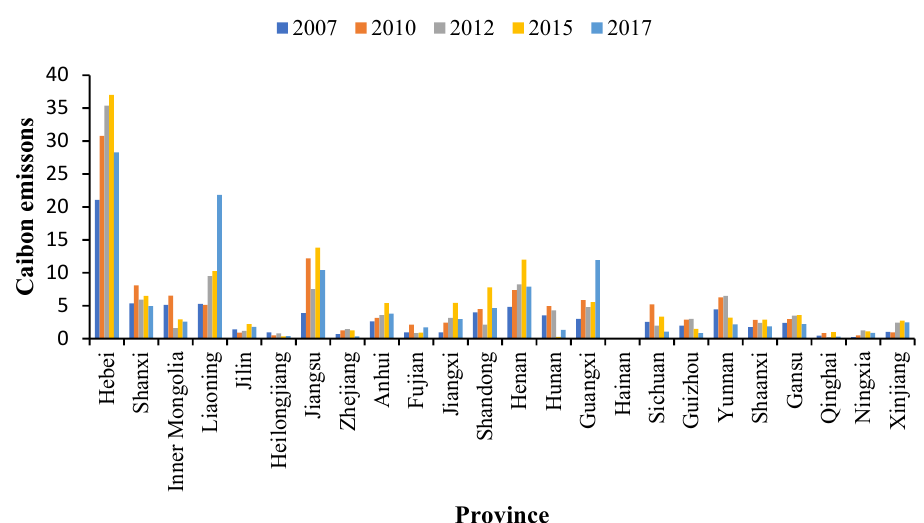
Figure 7. Carbon change in the metal industry.